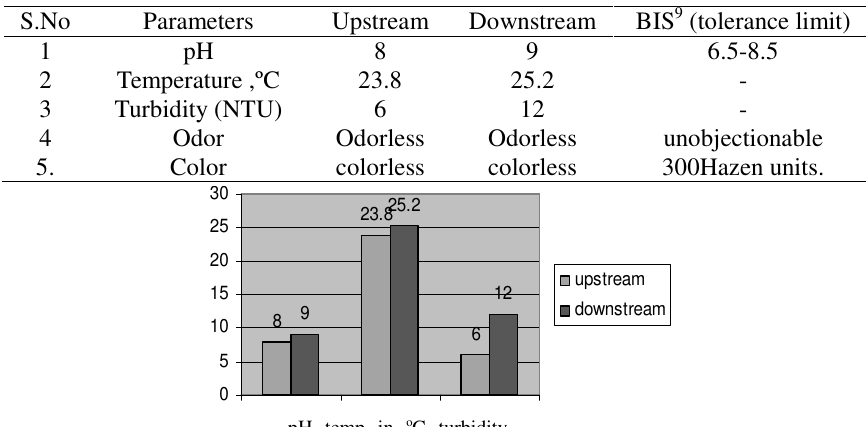
Table 1. pH, temperature, turbidity, color and odor of upstream and downstream samples.